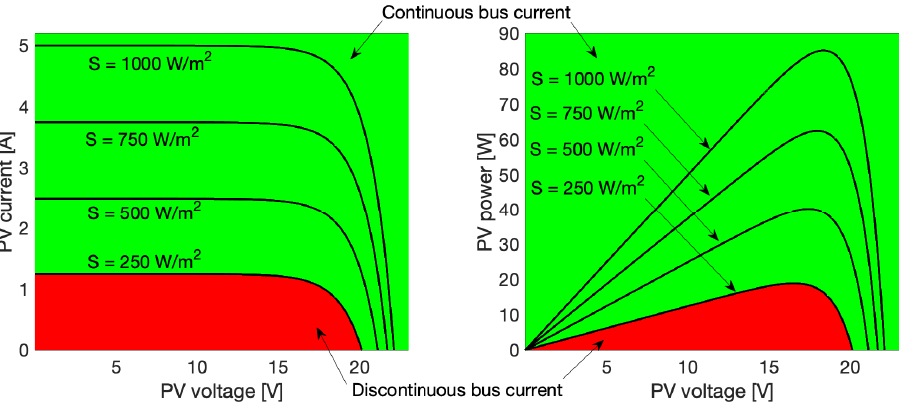
Figure 12. Electrical characteristics of the PV panel.